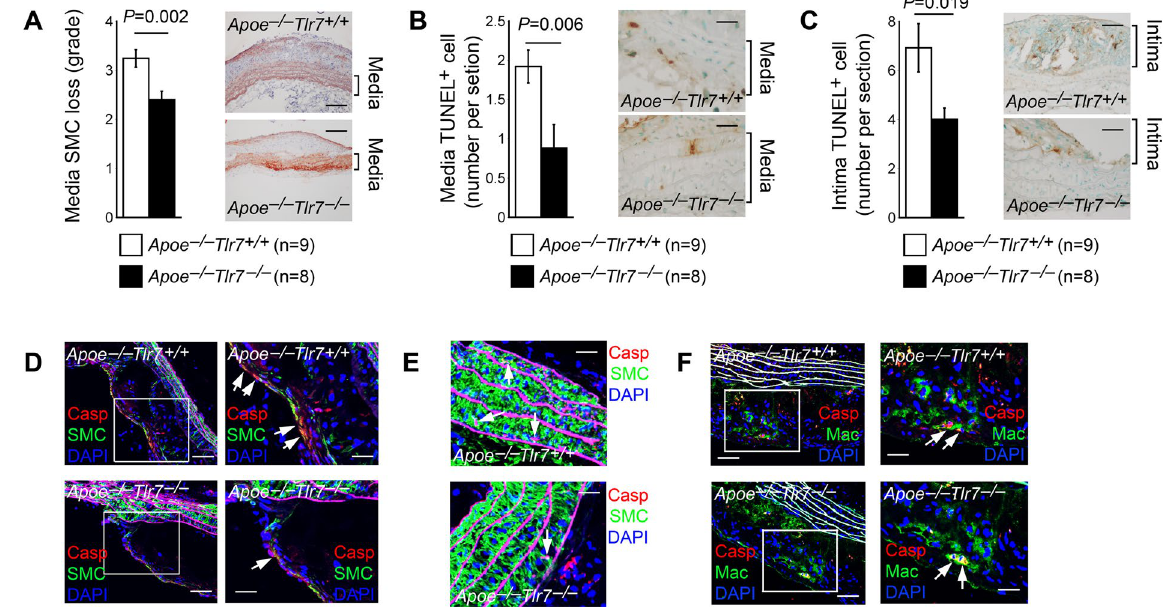
Figure 5. TLR7 deficiency reduces aortic arch atherosclerotic lesion SMC loss and cell apoptosis in male Apoe − / − mice. ( A) Media SMC loss grade. Scale: 200 µ m. ( B) Media TUNEL-positive apoptotic cell number per section. Scale: 100 µ m. ( C) Intima TUNEL-positive apoptotic cell number per section. Scale: 100 µ m. Media with clear elastic fibers and intima are framed. Representative images are shown to the middle panels. ( D) Immunofluorescent double staining detected cleaved caspase-3 (Casp)-positive apoptotic SMC in the intima. Scale: 200 µ m. Inset scale: 100 µ m. ( E ) Cleaved caspase-3 (Casp)-positive apoptotic SMC in the media. Scale: 100 µ m. ( F ) Cleaved caspase-3 (Casp)-positive apoptotic macrophages (Mac) in the lesions. Scale: 200 µ m. Inset scale: 100 µ m. Arrows indicate apoptotic cells. Numbers and genotypes of mice are indicated in the